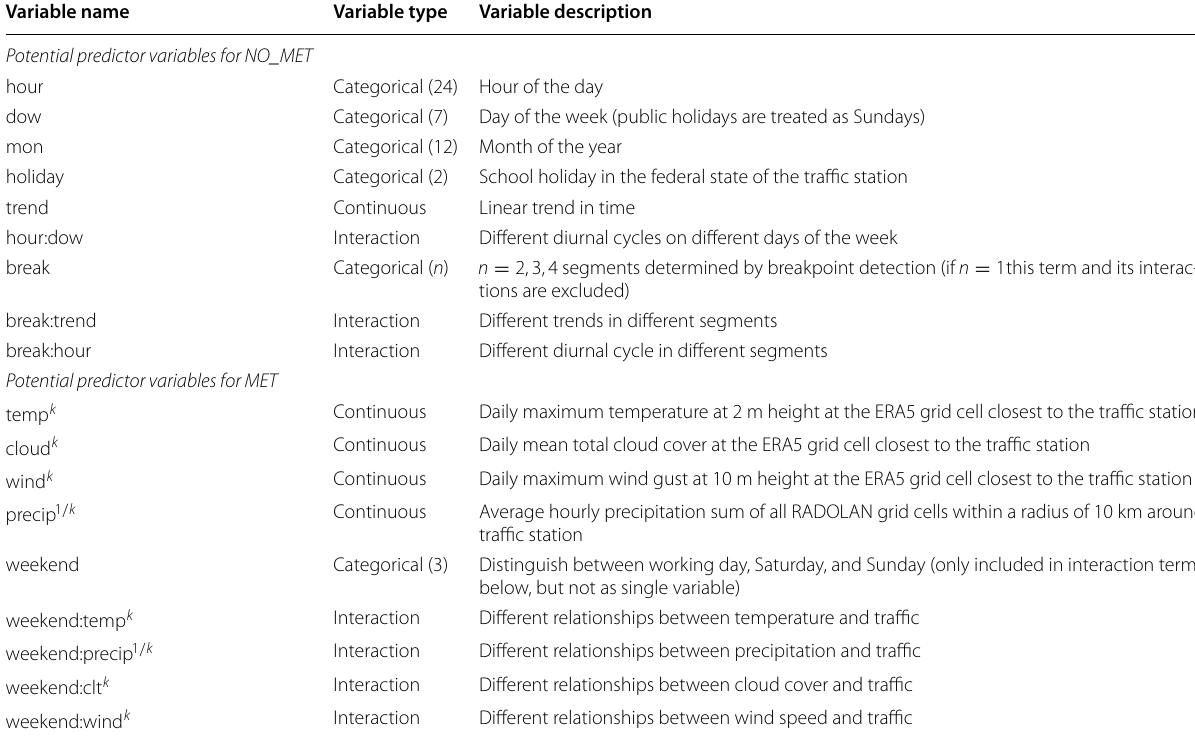
Table 2 Description of predictor variables and interaction terms included in models without (NO_MET) and with (MET) meteorological